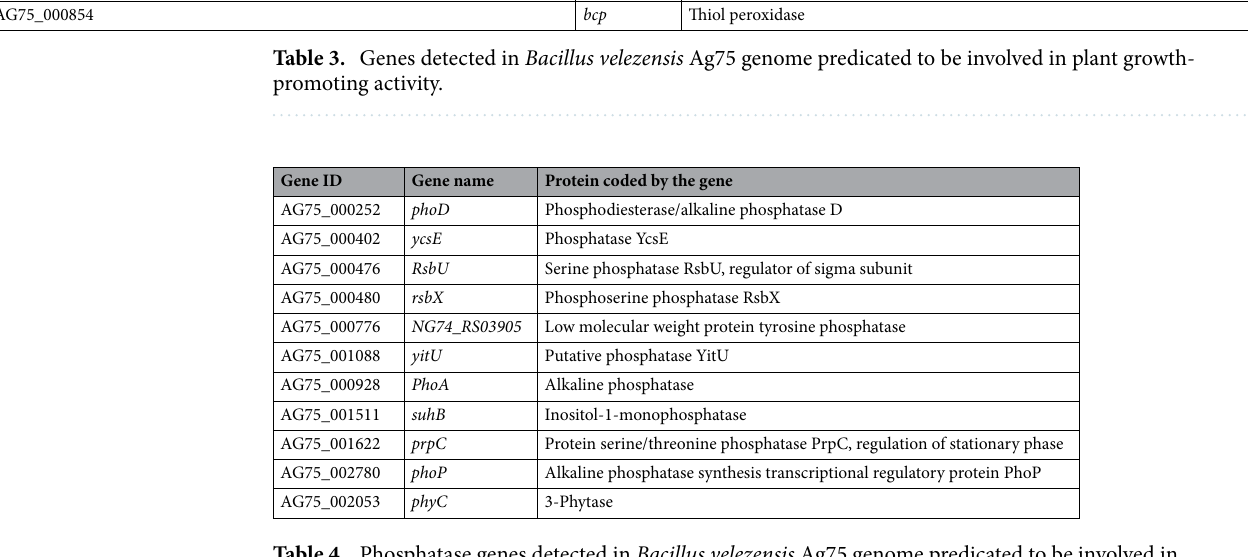
Table 4. Phosphatase genes detected in Bacillus velezensis Ag75 genome predicated to be involved in phosphorus